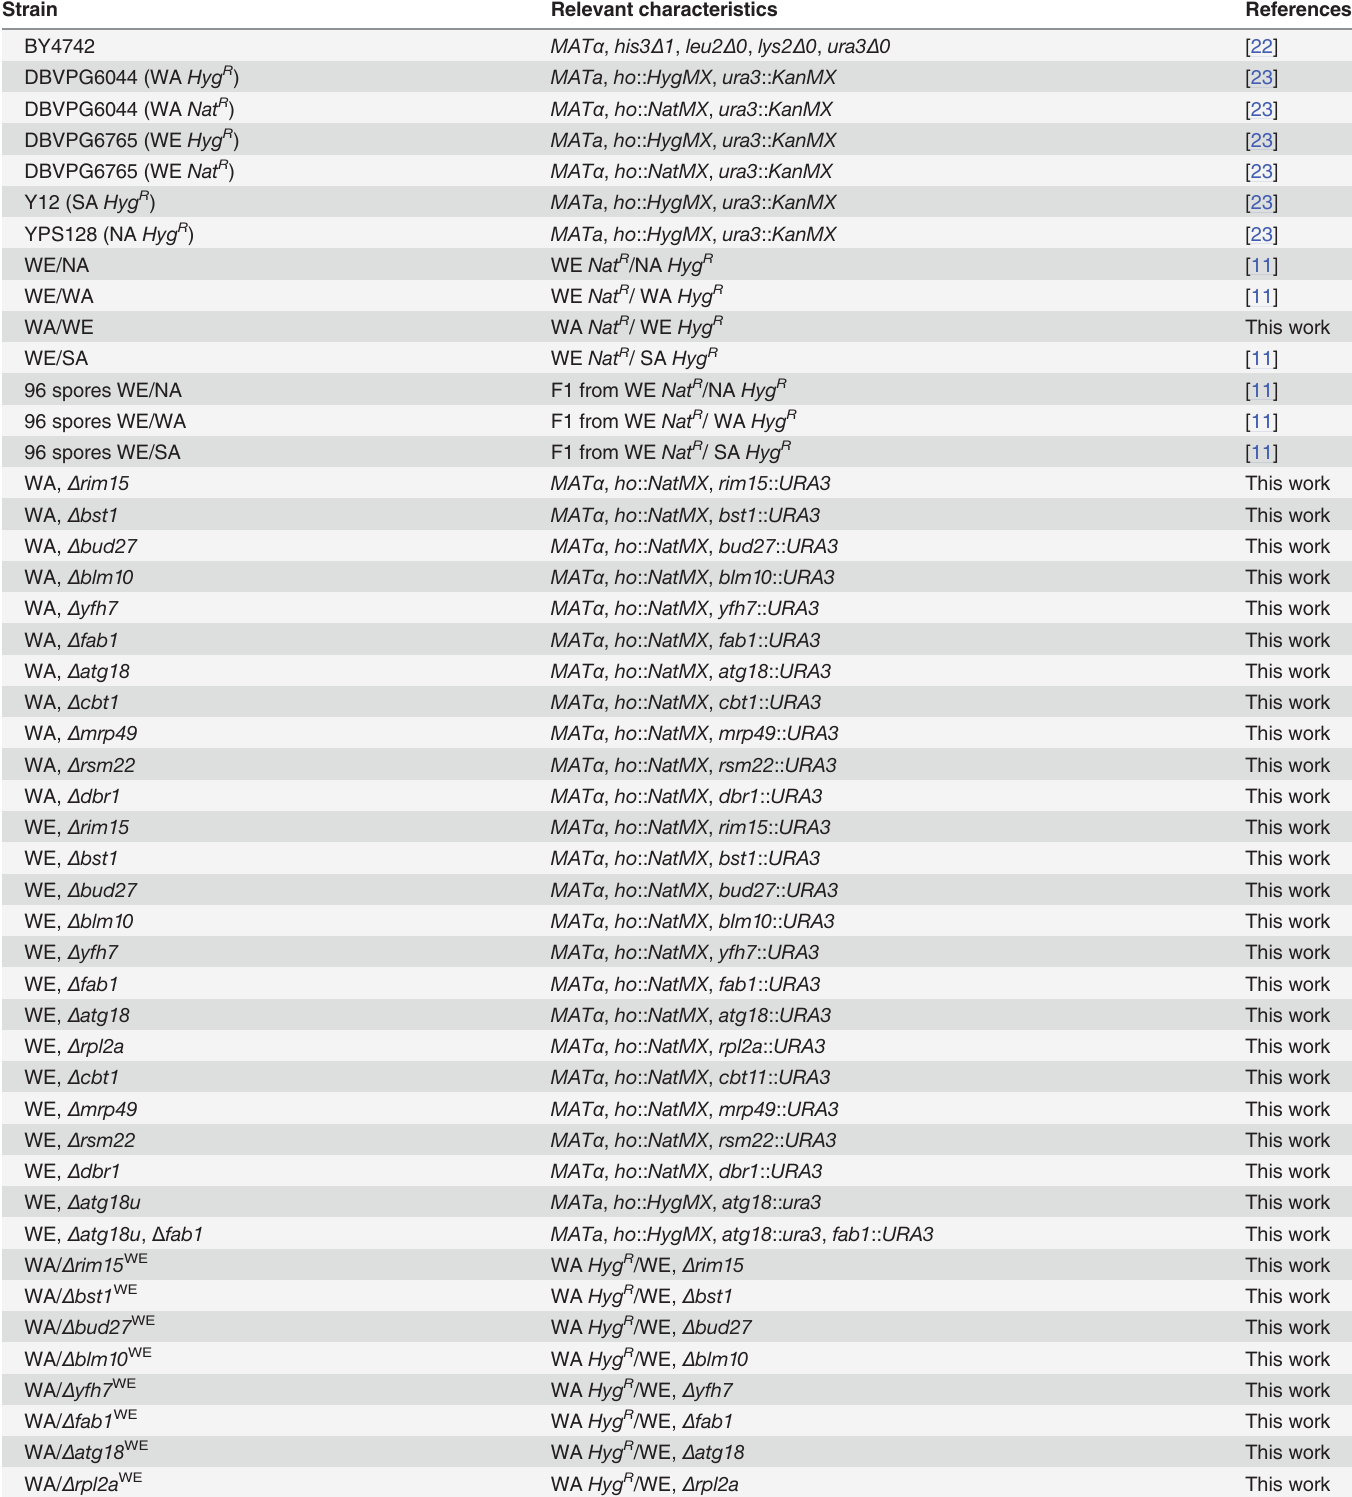
Table 1. Strains and plasmid used in the study. Strain Relevant